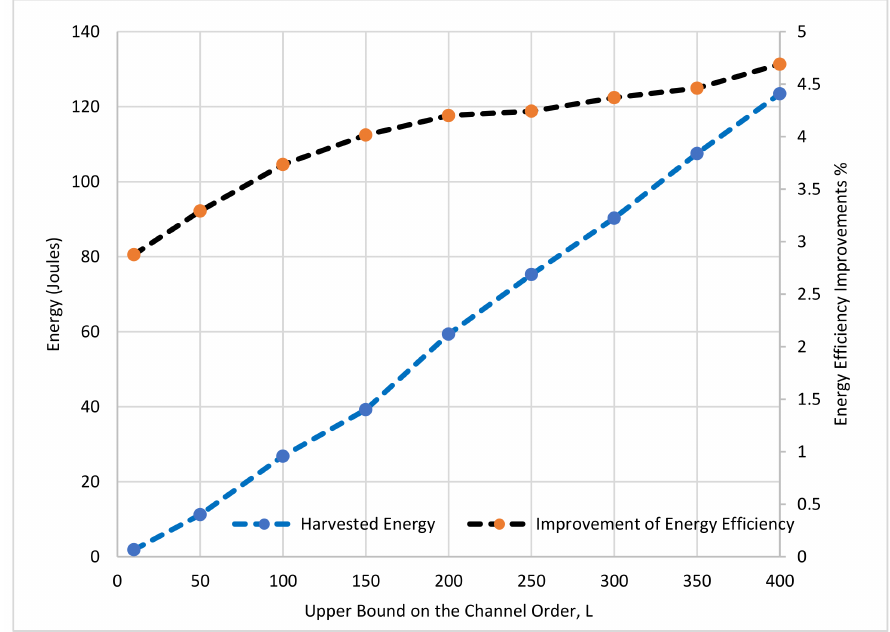
Figure 12. The performance of the TDS-OFDM using TS-SWIPT verses the maximum channel order, L